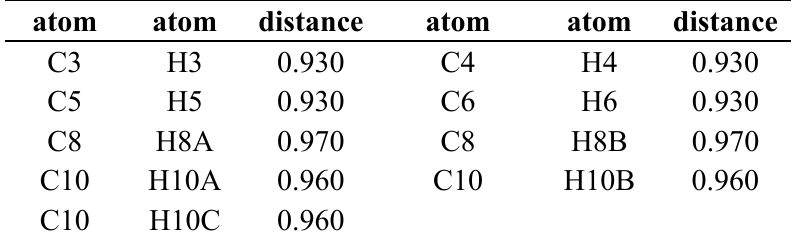
Table 8. Bond lengths involving hydrogen's (Å) for compound 5 .